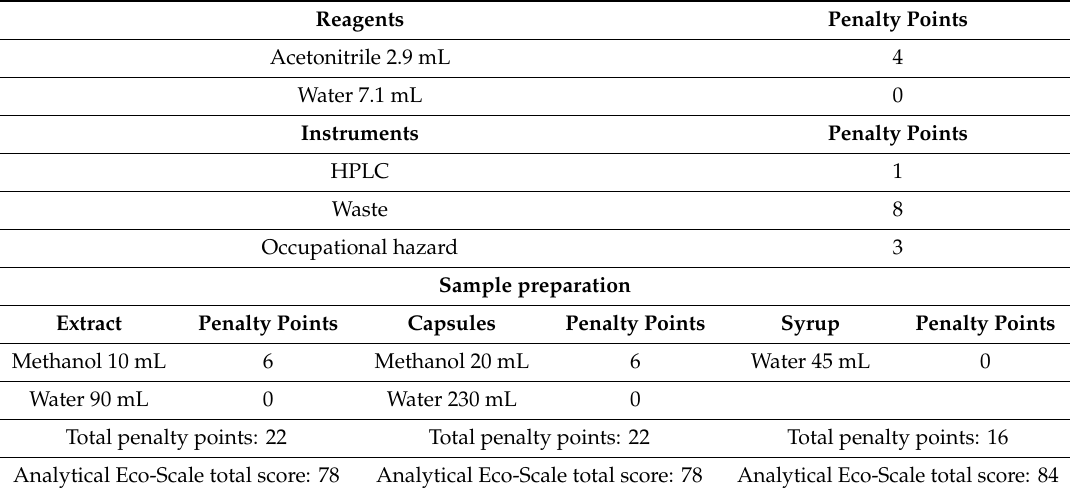
Table 5. Calculation of penalty points for the HPLC method in the analysis of one